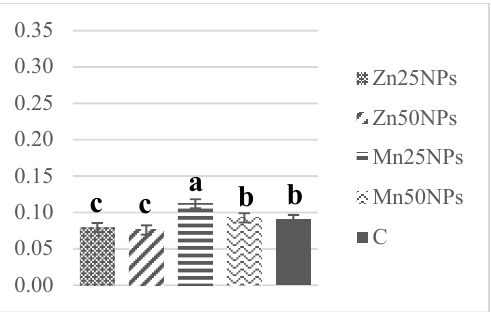
Figure 12. SOD activity (U/mg) in samples of turkey sperm stored for 48 h with or without (C) the addition of ZnNPs and MnNPs. * Different letters (a, b, c) indicate statistically significant differences at p ≤ 0.05. The bars with various letters are significantly different from one another.